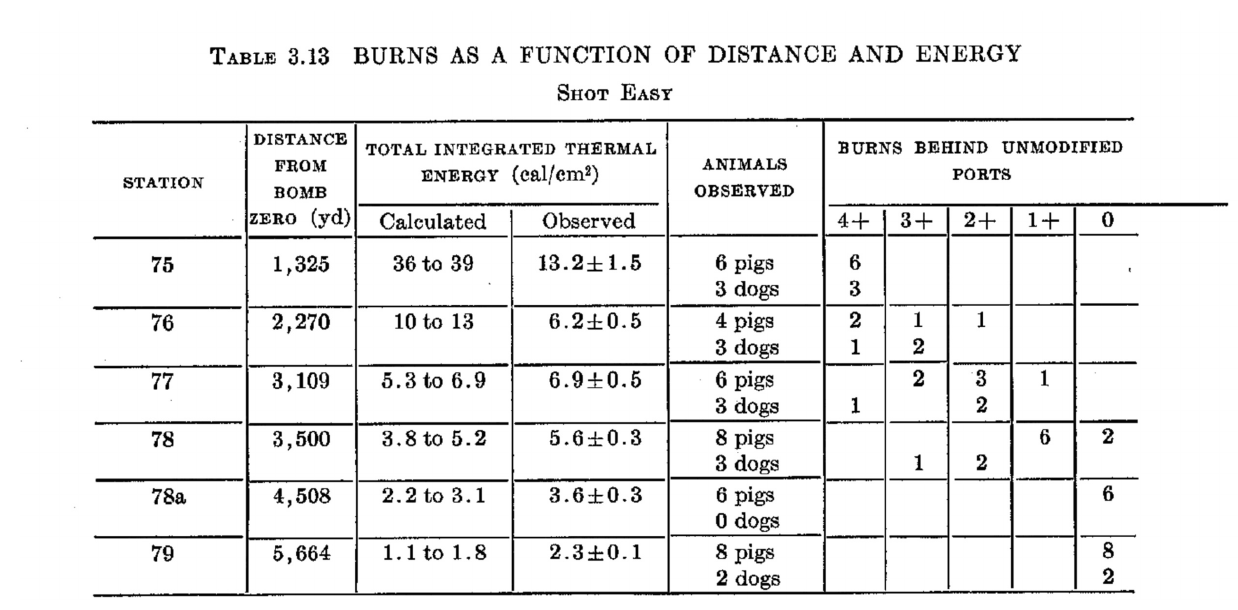
Figure 8: A table from a test report displays the relative effects of exposure on animals placed at different distances from detonation during Operation Greenhouse ( Operation Greenhouse, Scientific Director’s Report, Annex 2.7 Thermal- Radiation Injury 1951,